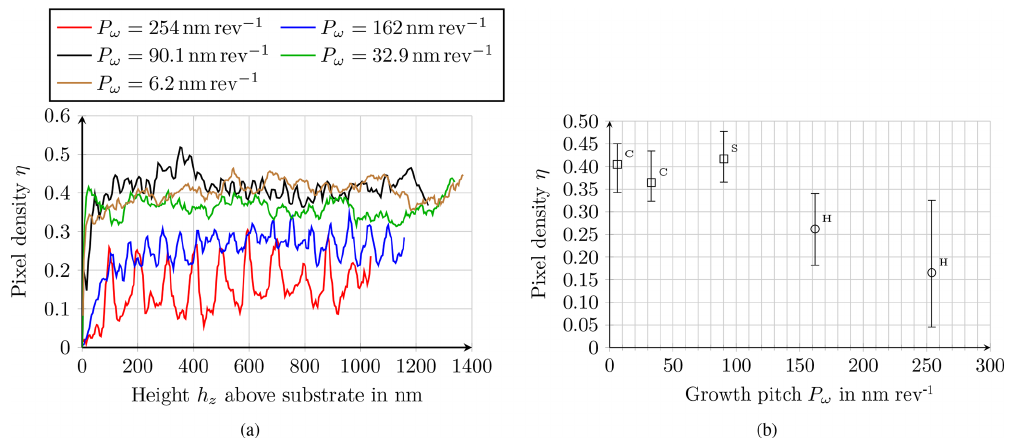
Figure 9. Pixel density across the layer thickness for different layer structures with different growth pitch values P ω for a deposition angle α of 80 ◦ as a function of (a) height h z above the substrate and (b) pixel density η . C – columns, S – screws, H – spirals. The bars indicate the variation along the height coordinate of the layer, with 95% of the η values lying within the bars.